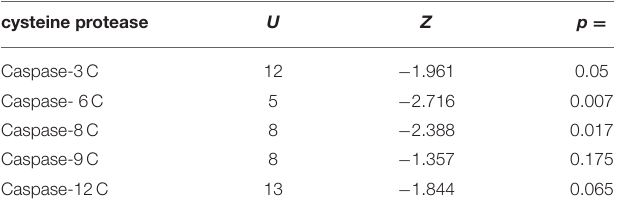
TABLE 2 | Comparison of survival and no-survival patients evaluated by the 28-day mortality. cysteine protease U